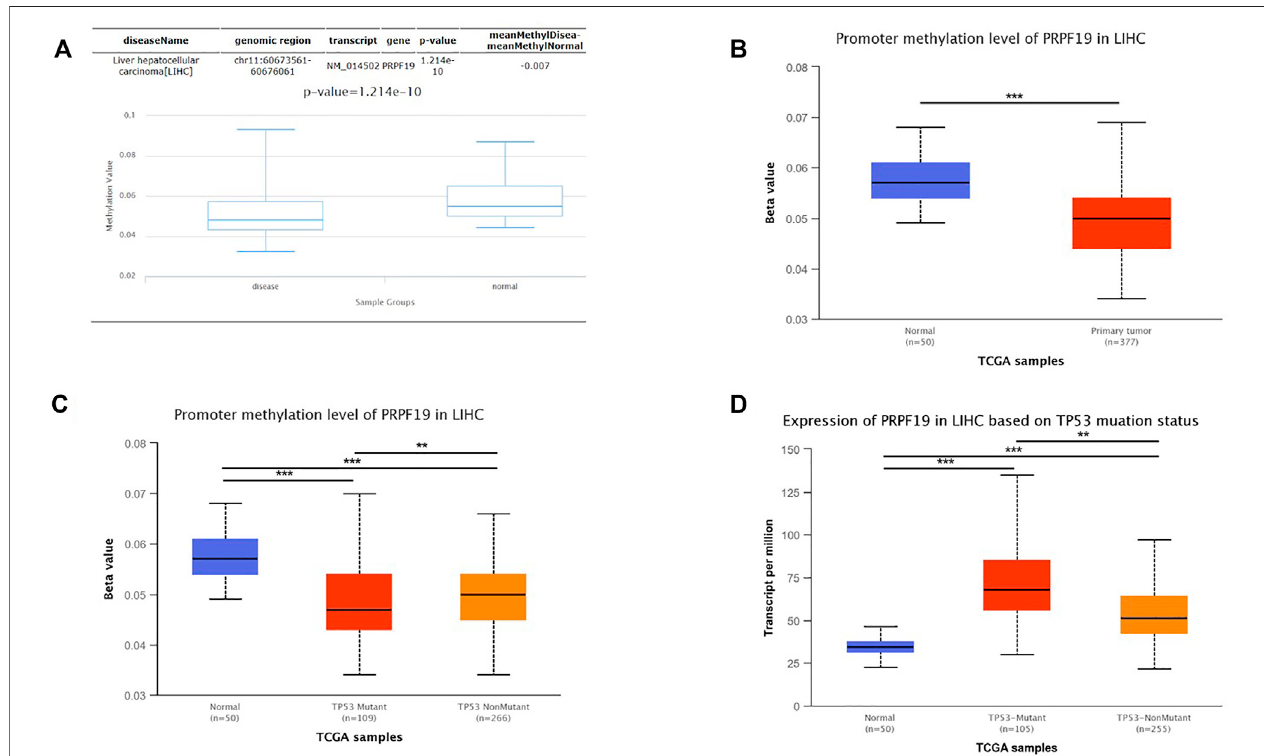
FIGURE7| AnalysisoftherelationshipbetweenPRPF19expressionandpromotermethylationlevelofPRPF19andTP53alteration statue. (A) Differentialanalysis of methylation value between LIHC and Control via DiseaseMeth. (B) Differential analysis of between LIHC and Control via UALCAN. (C) Correlation between promoter methylation level of PRPF19 between TP53 statue. (D) Differential analysis of PRPF19 expression between wild-type TP53 wild-type and mutated TP53.